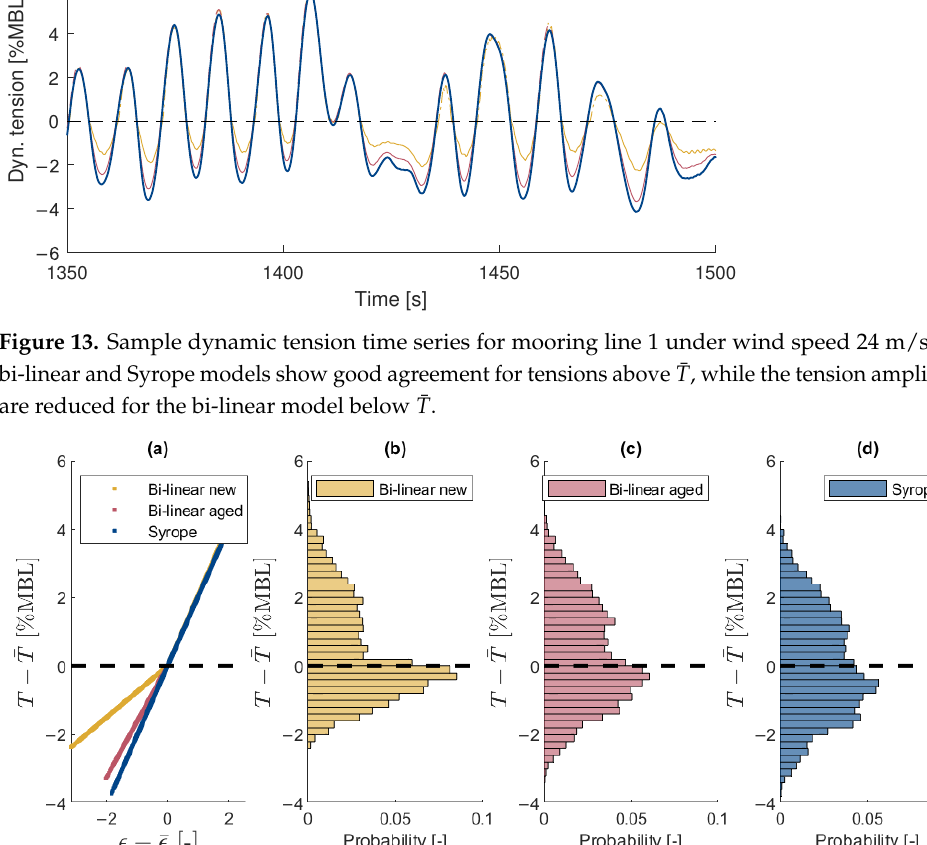
Figure 14. ( a ) Tension-elongation relationship calculated from the time series of tension in mooring line 1 under wind speed 12 m/s. ¯ T and the corresponding mean elongation, ¯ (cid:101) has been removed, yielding the dynamic variations in the mooring line. ( b – d ) Empirical probability distribution of the instantaneous dynamic tension in mooring line 1 for wind speed 12